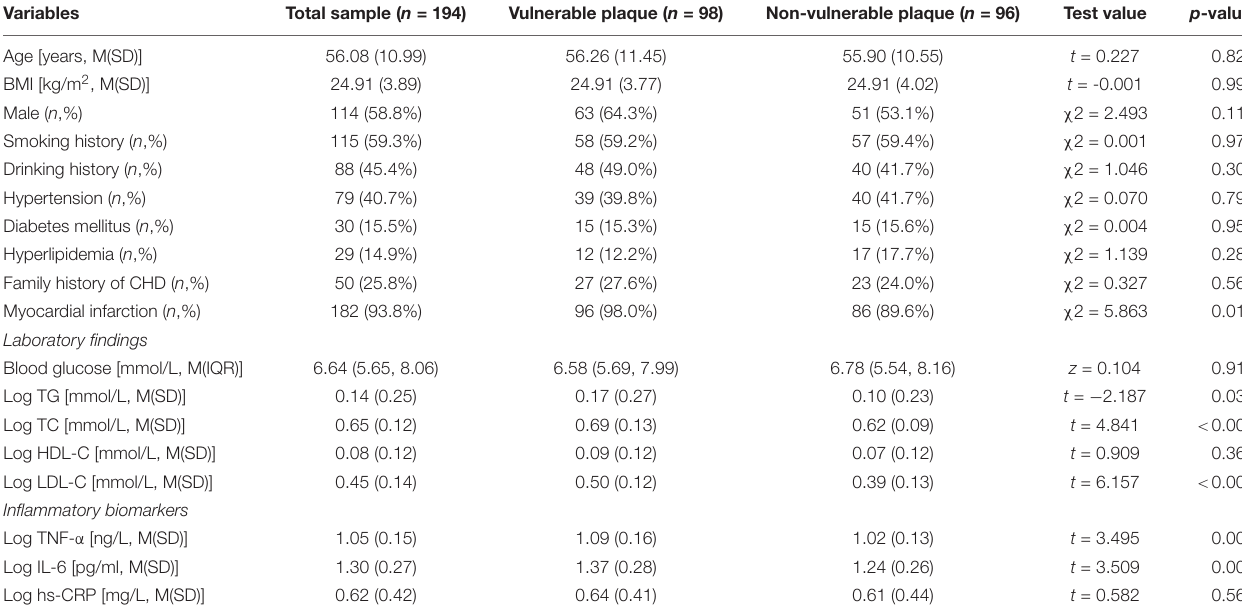
TABLE 1 | Characteristics of vulnerable plaque and non-vulnerable plaque individuals ( N = 194).